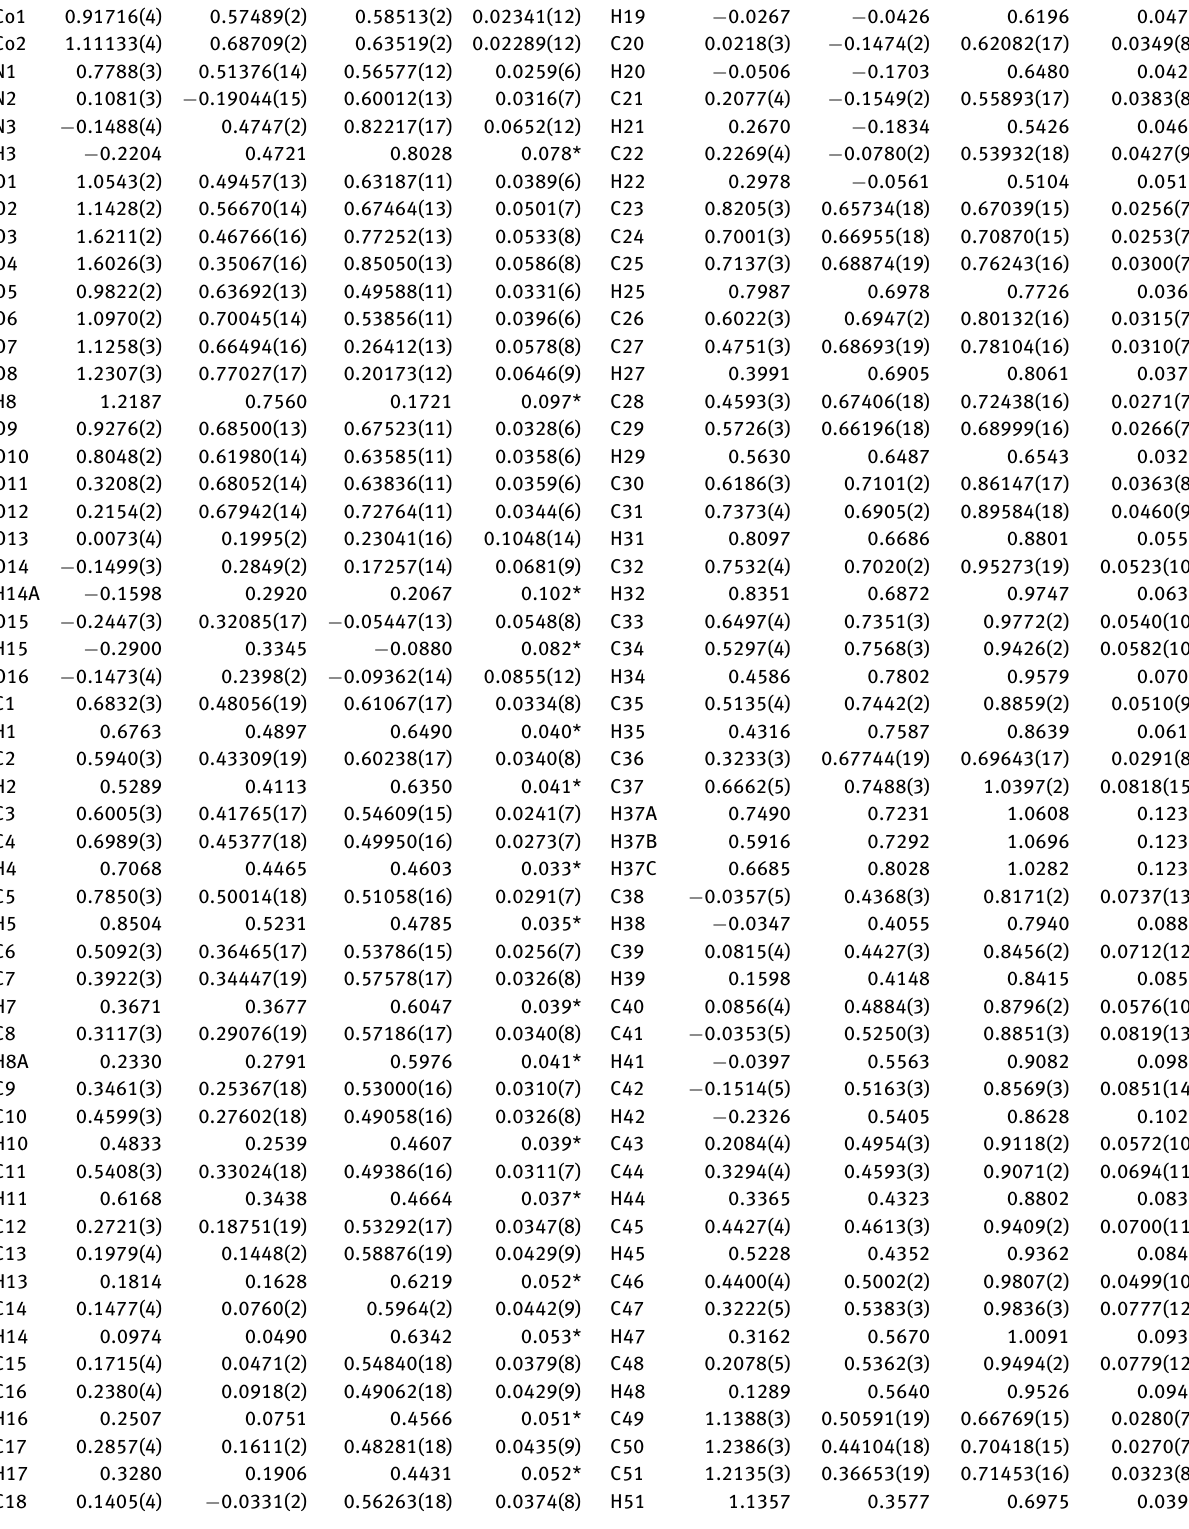
Table 2: Fractional atomic coordinates and isotropic or equivalent isotropic displacement parameters (Å 2